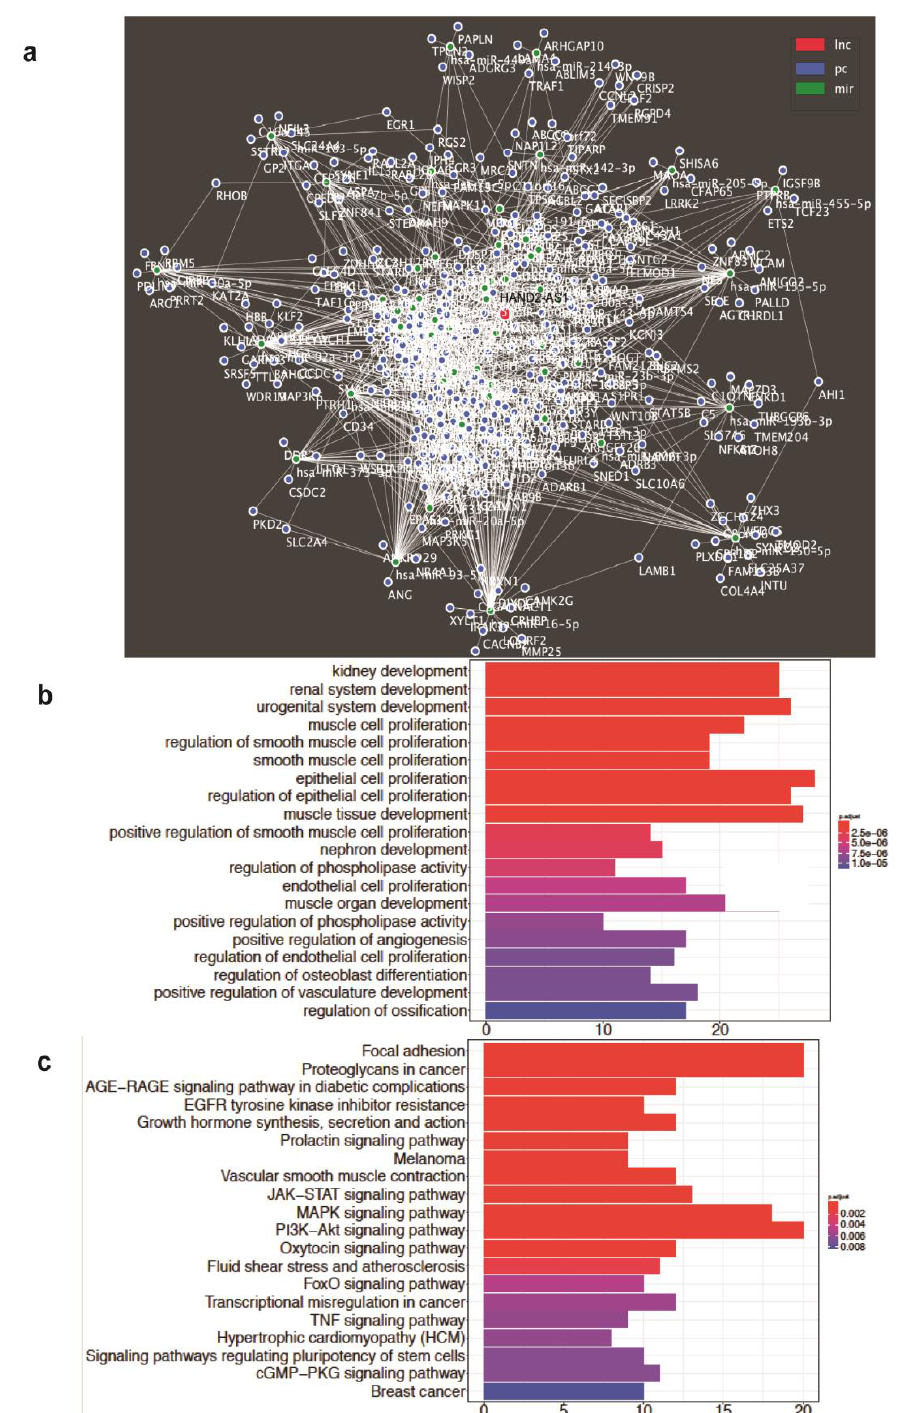
Figure 6. ( a ) Proposed competing endogenous RNA (ceRNA) network constructed bioinformatically for HAND2-AS1 with its target miRNAs (predicted using webtool miRTarBase) and their putative mRNA targets in HGSC (predicted using the webtool Diana); ( b ) All GO biological process terms; and ( c ) all KEGG pathways enriched by the HAND2-AS1 competing endogenous RNA (ceRNA) activity in HGSC obtained using the GDCRNATools R-package.